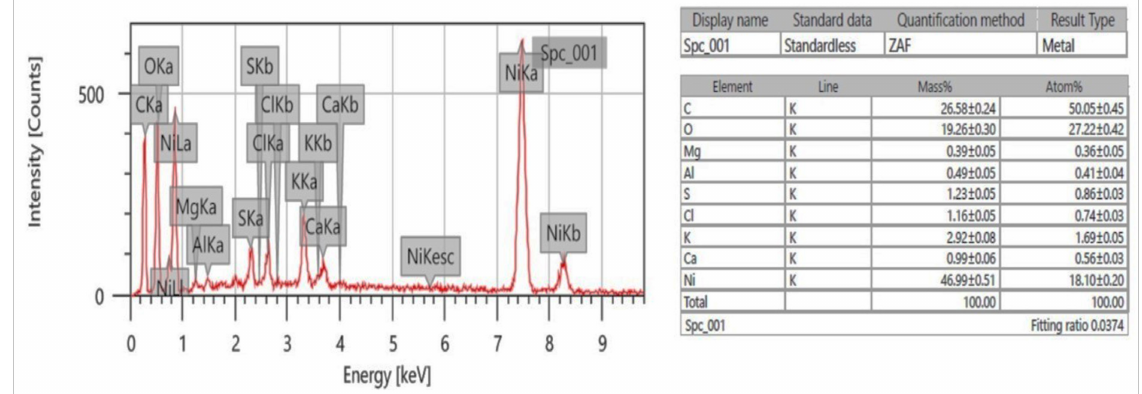
Figure 2. Energy-dispersive X-ray (EDAX) spectra depicting the chemical composition of the synthesized NiO NPs.